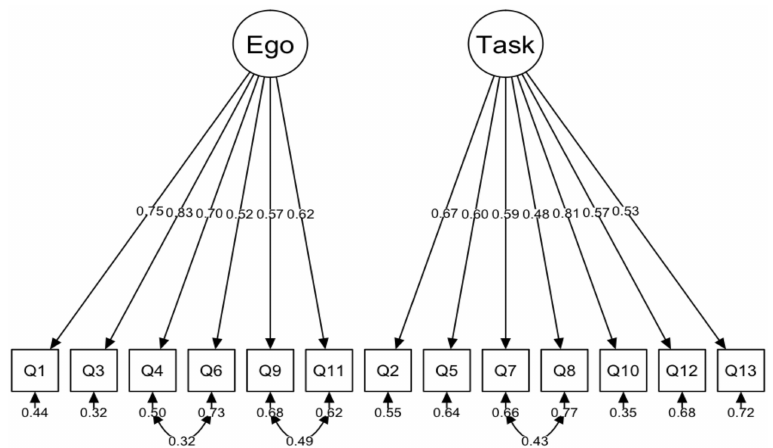
Figure 5. TEOSQ Questionnaire factor model with covariance for errors: 4–6, 7–8, 9-11, (Chi-sq = 217.43, df = 62, p < 0.001, CFI = 0.948, TLI = 0.934, SRMR = 0.052, RMSEA = 0.062, CI.90 [0.053–0.071]).